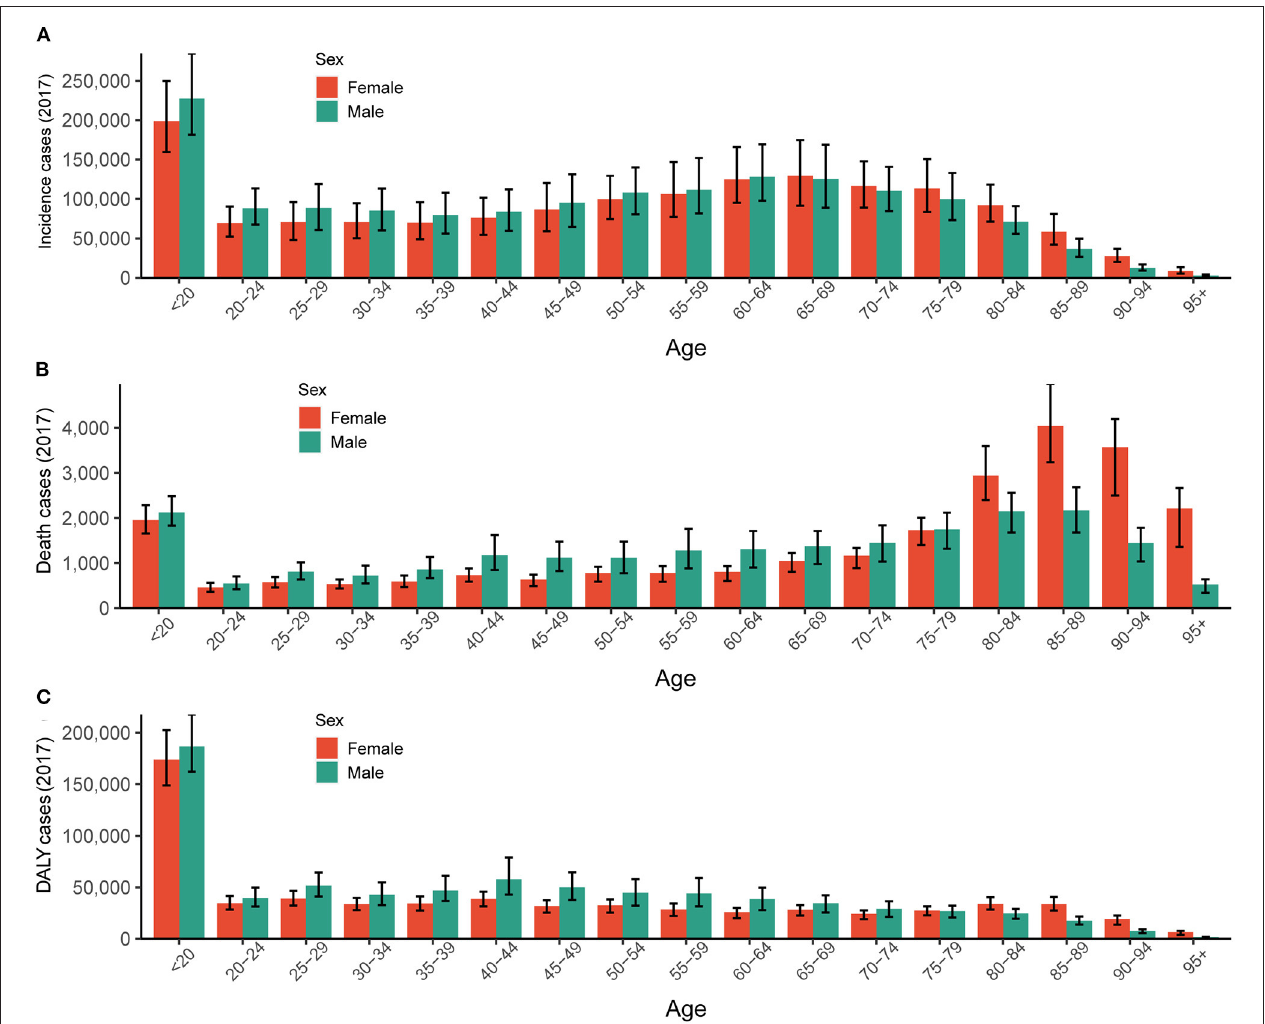
FIGURE 6 | The global burden of myocarditis in both genders and different age groups in 2017. (A) The absolute number of incidence cases. (B) The absolute number of death cases. (C) The absolute number of DALYs. DALY, disability-adjusted life